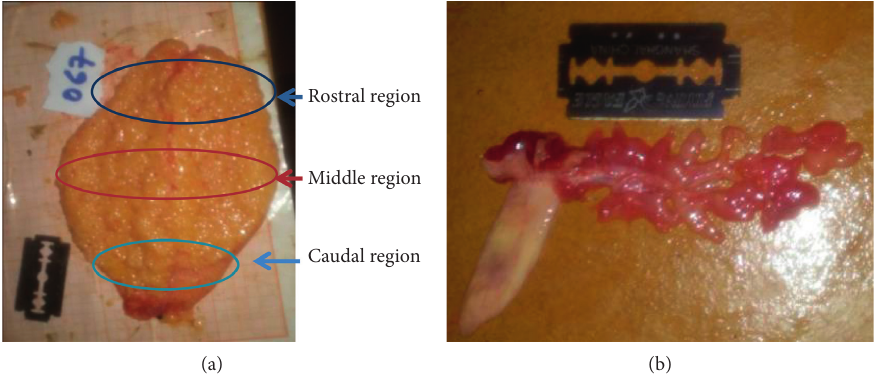
Figure 2: (a) Ovaries of C. nigrodigitatus , (b) testes of C. nigrodigitatus